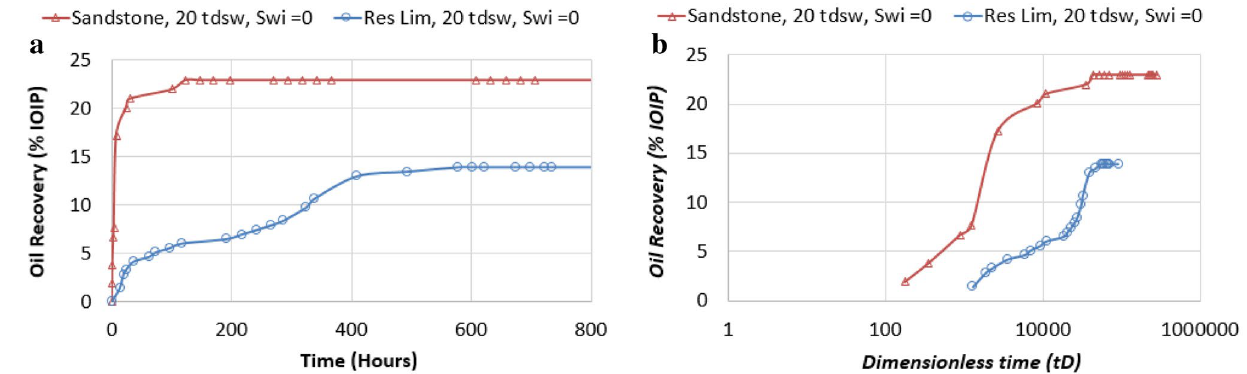
against time and right picture ( b ) is plotted versus dimensionless time ( t